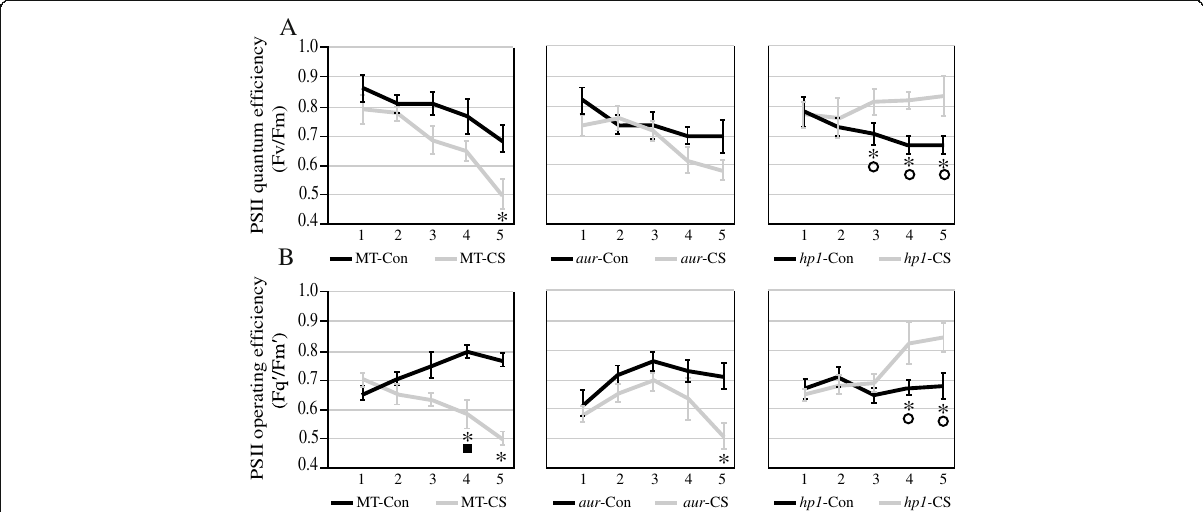
Fig. 3 Comparison of a PSII potential quantum efficiency (Fv/Fm) and b PSII operating efficiency (Fq ′ /Fm ′ ) in leaves of the wild-type genotype (MT) and aurea ( au ) and high pigment1 ( hp1 ) mutants of tomato cv. Micro-Tom under control (Con) and chilling stress (CS) for 5 days. Blue lines represent data for control and green lines show data for stress treatment. Symbols that are not similar show significant differences (calculated by Tukey ’ s test, P < 0.05). Comparisons between the control and stress treatments within the same genotype were indicated as asterisks, whereas solid squares represent comparisons among genotypes under the control treatment and circles were used for comparisons among genotypes under the stress treatment